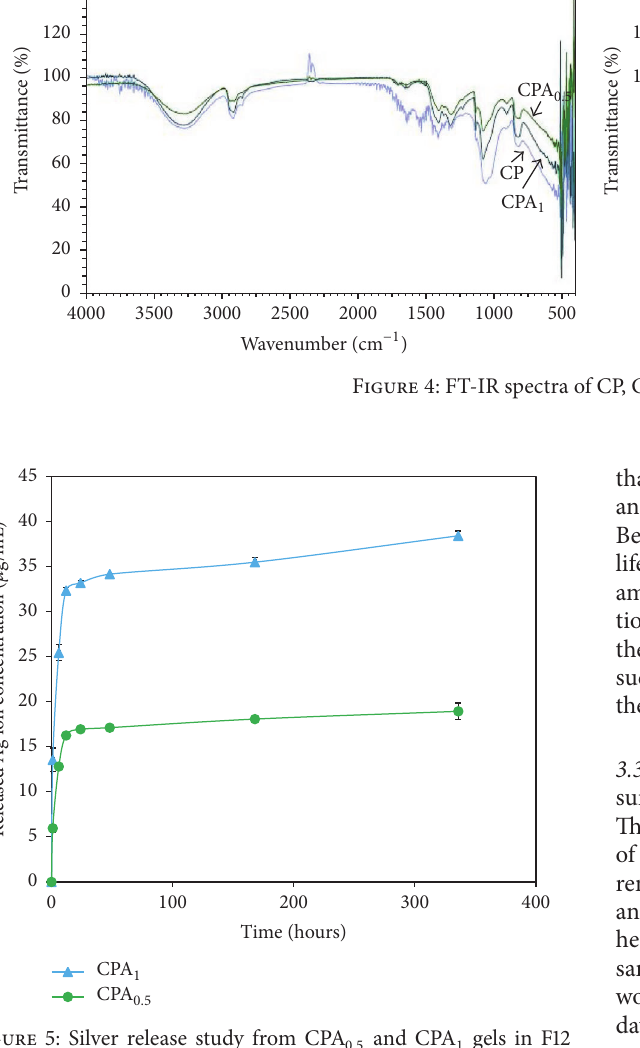
Figure 5: Silver release study from CPA 0.5 and CPA 1 gels in F12